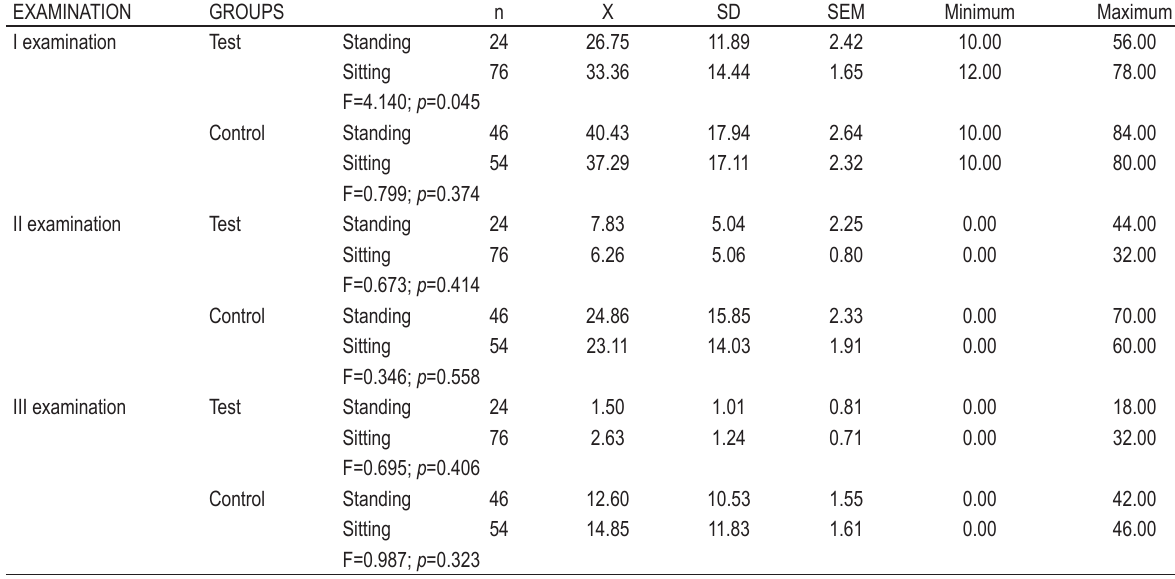
TABLE 8. The influence of the occupation type on the percentage of disability during all three examinations in both examined groups